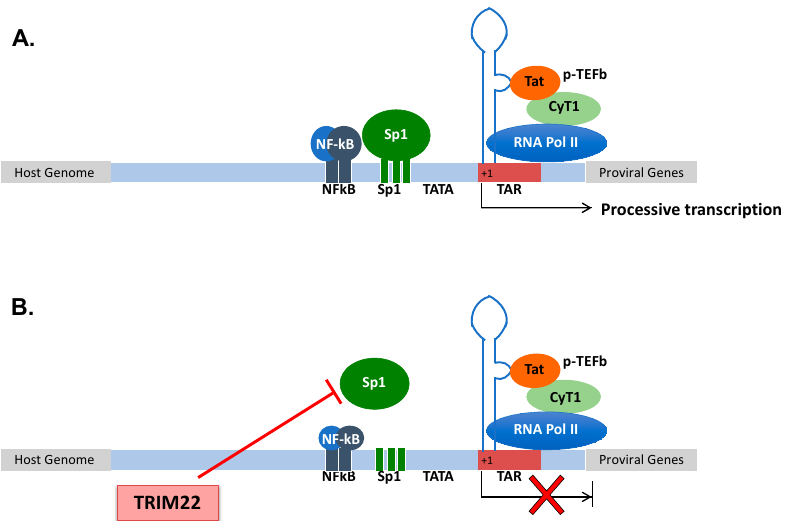
Figure 1. ( A ) Structural organization of the HIV-1 promoter. HIV-1 transcription starts at the promoter region in the 5 ′ LTR. Processive HIV-1 transcription is driven by the Tat protein that recruits the p-TEFb complex to the TAR RNA. pTEFb promotes the phosphorylation of the RNA Pol II, enabling the elongation of the viral transcripts. Upstream of the initiation of transcription (+1), three Sp1 and two NF-kB binding sites control the levels of basal transcription and response to inflammatory signals, respectively. ( B ) TRIM22 inhibits HIV-1 basal transcription by preventing Sp1 binding to the HIV-1 promoter, thus contributing to the maintenance of latent HIV-1 infection.